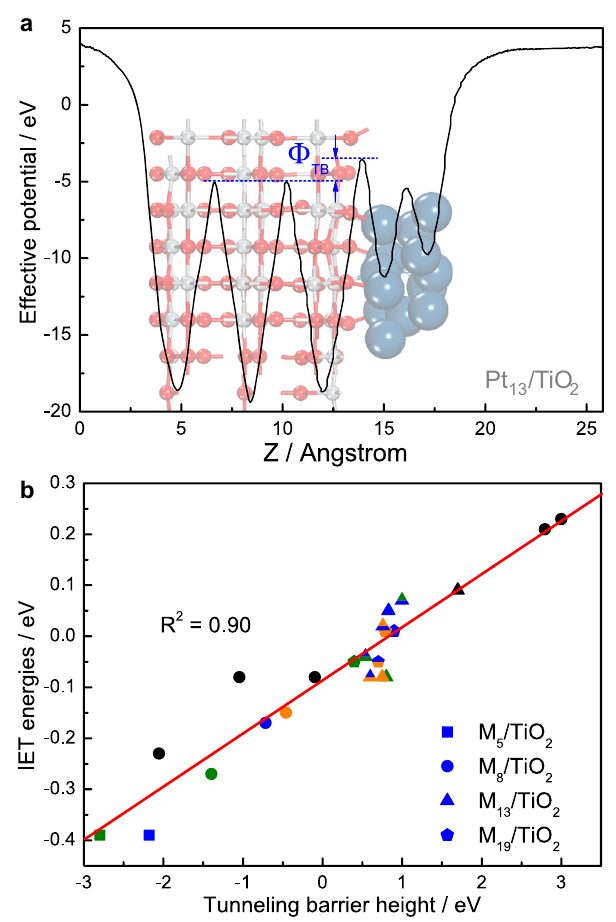
Fig. 4 Calculated effective potential curve and the generalized linear correlation. a Schematic of the effective potential (black curve) and Φ TB (indicated by blue arrows) of Pt 13 /TiO 2 using the hybrid HSE06 functional, as well as b the linear correlation between IET energies and Φ TB on a wide range of metal/TiO 2 composites. While Pt, Rh, and Cu are highlighted in blue, olive, and orange color, the M 5 /TiO 2 , M 8 /TiO 2 , M 13 /TiO 2 , and M 19 /TiO 2 are illustrated by solid square, dot, triangle, and pentagon in plot b , respectively. Symbols fi lled with mixed colors represent alloyed metal particles, where the stacking pattern from surface to the interface is consistent with the top-down coloring